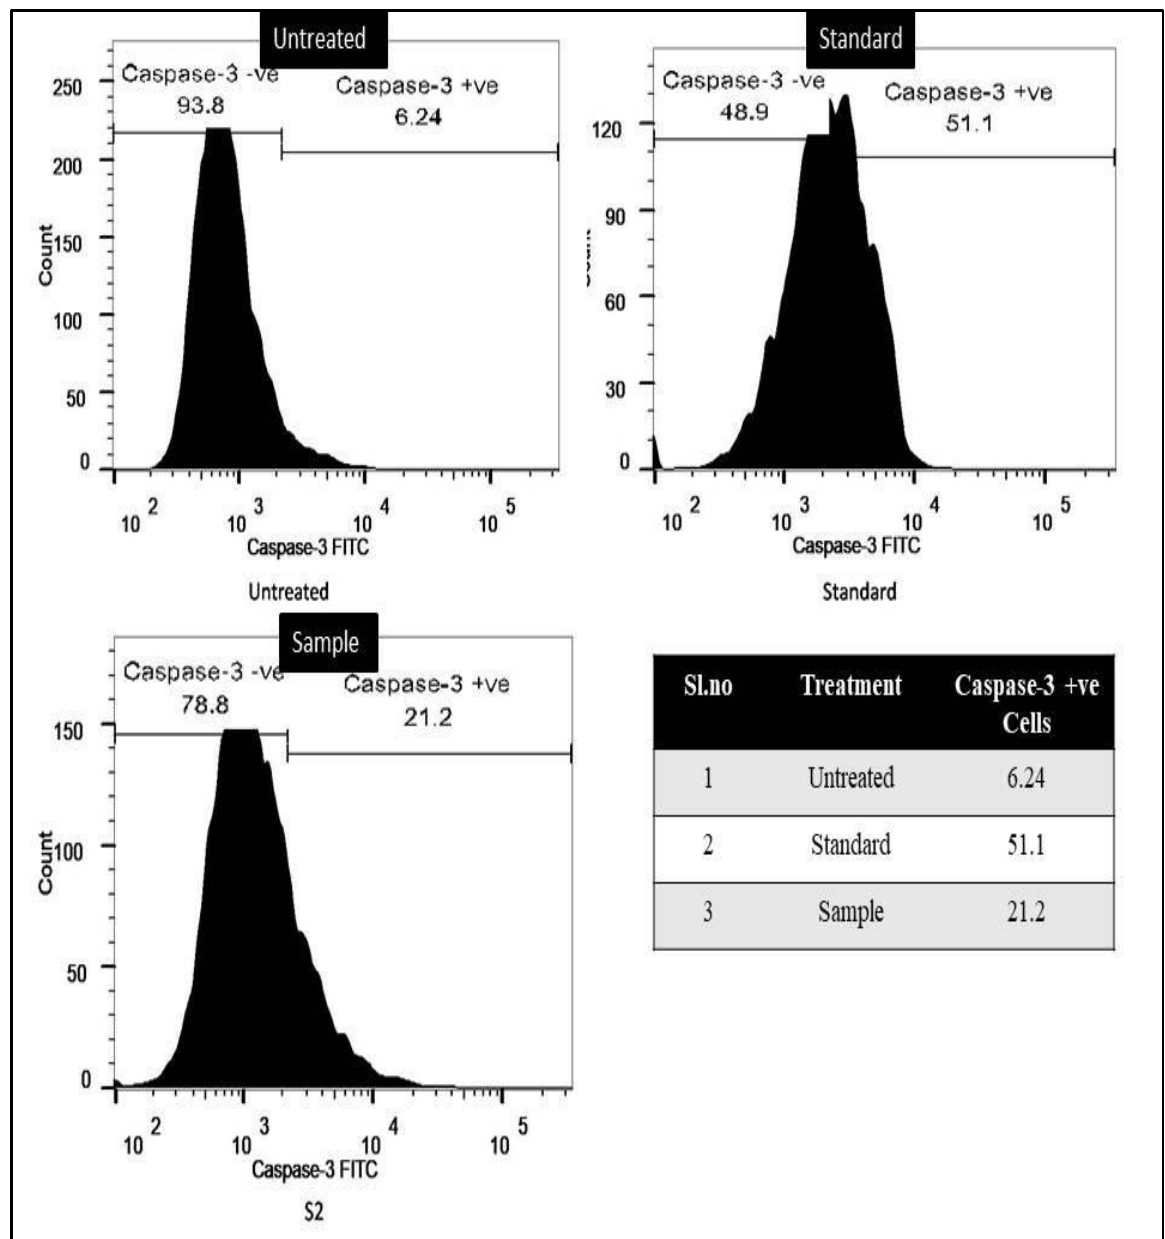
Figure 2. Confirmation of apoptosis induced by methanol extract of T. terrestris in the MCF-7 cell line through the caspase 3 assay.